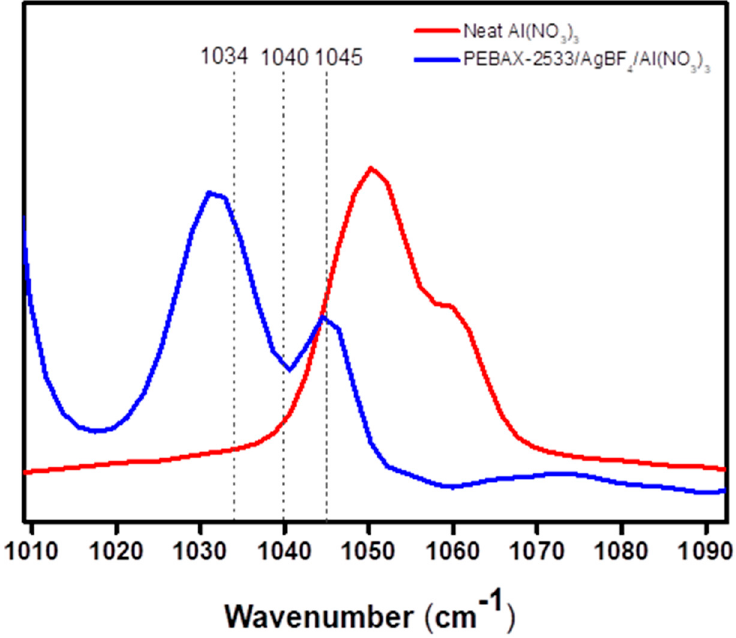
Figure 5. Raman spectra of NO 3 − ions in neat Al salt and PEBAX-2533/metal salt/Al salt complex.